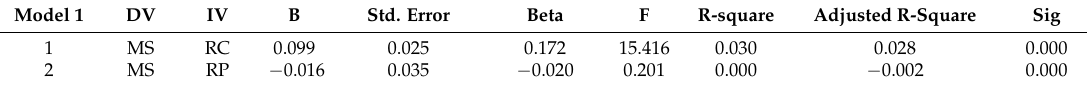
Table 6. Regression model for religiosity and marital